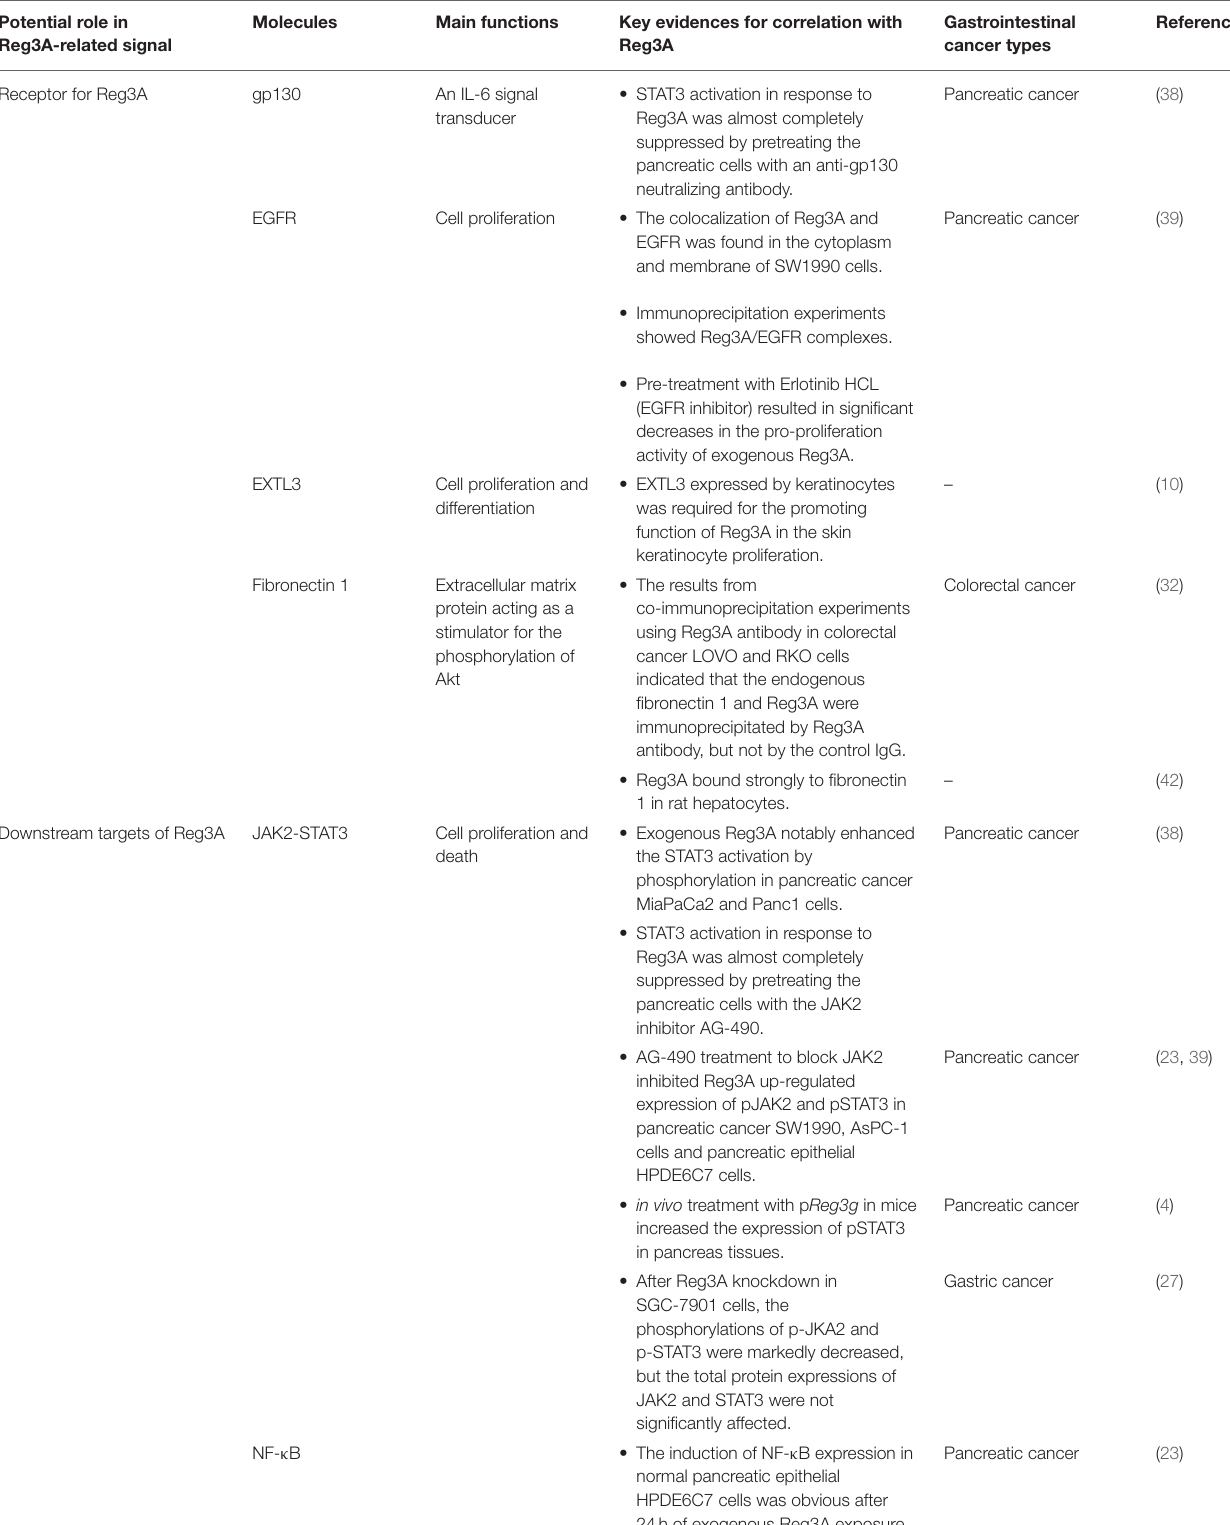
TABLE 1 | Summary of Reg3A-related signal